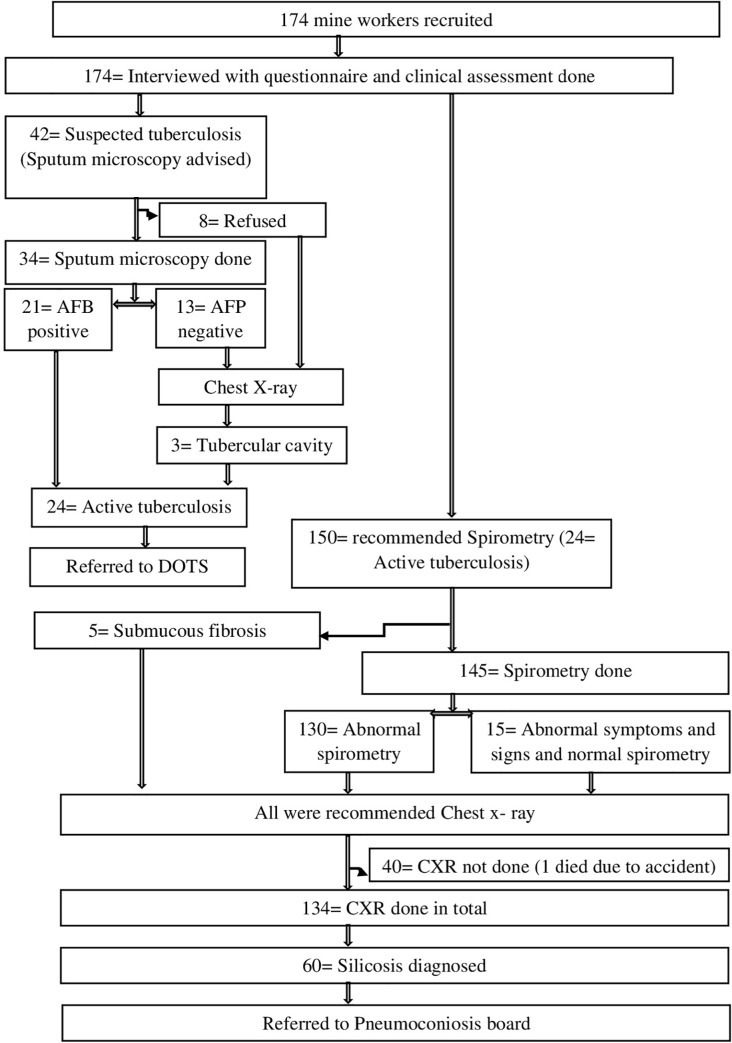
Flow diagram for investigation of mine workers.